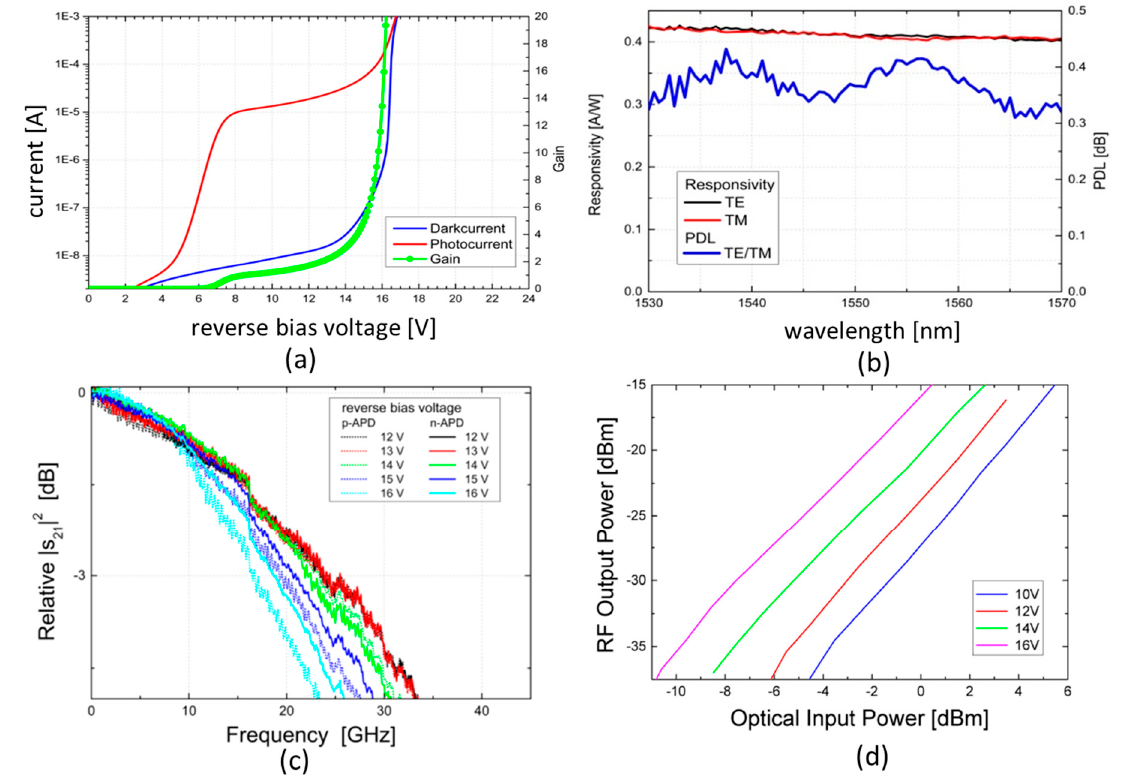
Figure 6. Measurement results of the avalanche photodiodes: IV curve including the calculated gain ( a ), responsivity and PDL versus wavelength ( b ), frequency response for various applied voltages ( c ), and linearity for various input powers ( d ).